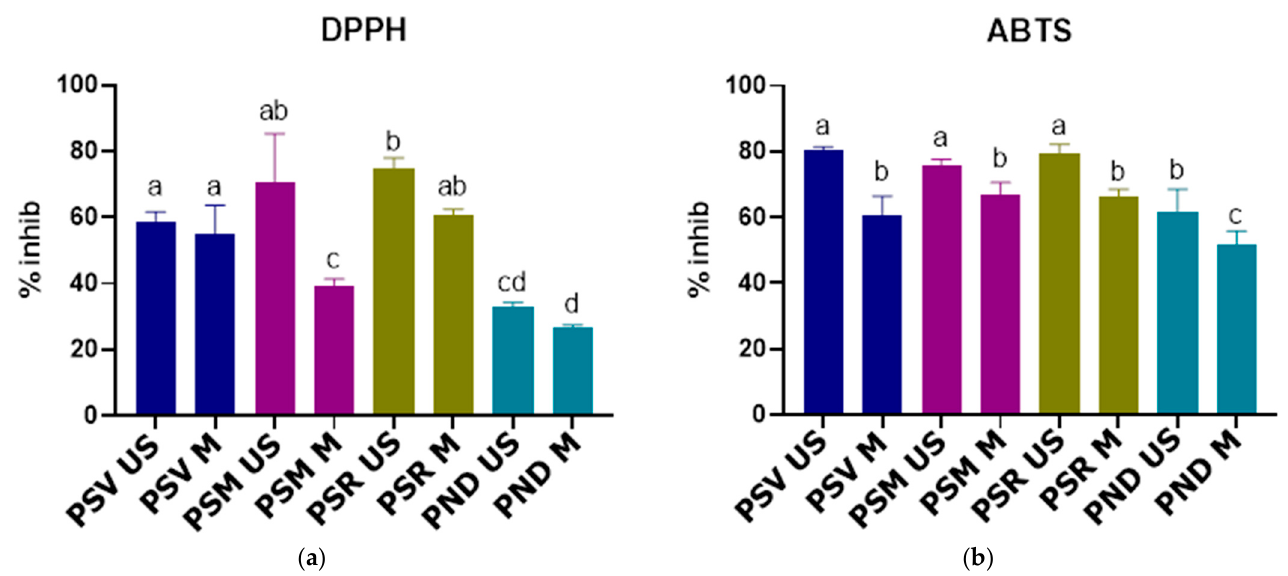
Figure 2. ( a ) Extract antioxidant activity (AOA) expressed by inhibition percentages (DPPH method); ( b ) extract AOA expressed by inhibition percentages (ABTS method); different letters indicate significant differences; PSV US— P. sylvestris (Vama) extract obtained by UAE; PSV M— P. sylvestris (Vama) extract obtained by MAE; PSM US— P. sylvestris (Medias